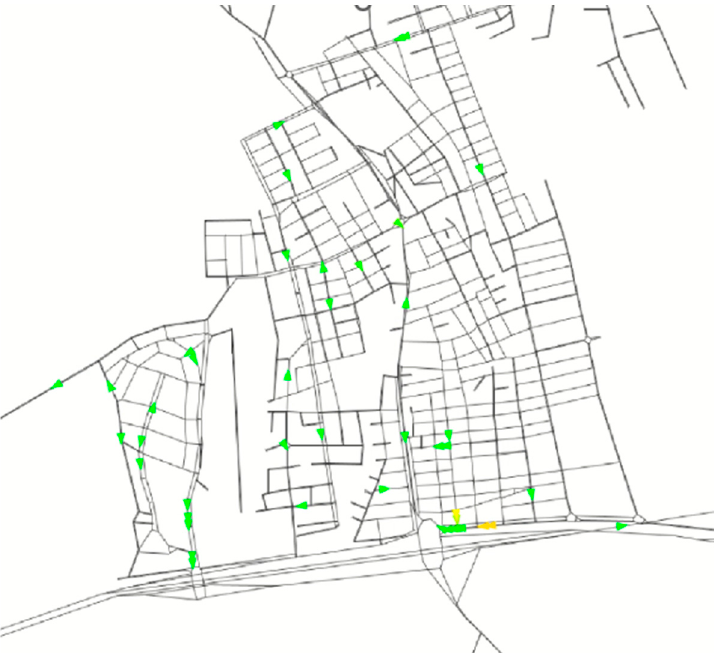
Figure 10. Screenshot of the synthetic agents in motion visualized on Via Simunto, in San Isidro, municipality of Granadilla de Abona, where the agents in green represent flowing traffic and in yellow collapsed traffic.